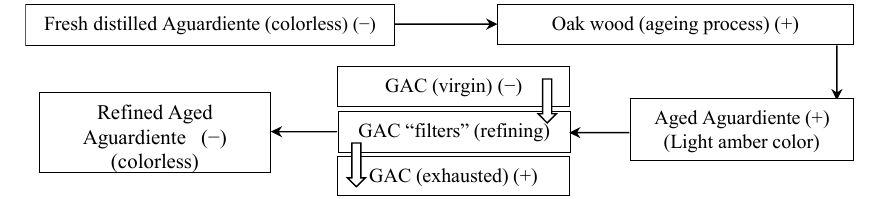
Figure 3. Diagram of the reaction trace. The “(+)” represents when the reaction with the ammonia solution occurs (amber color) and “( − )” when the color does not appear.